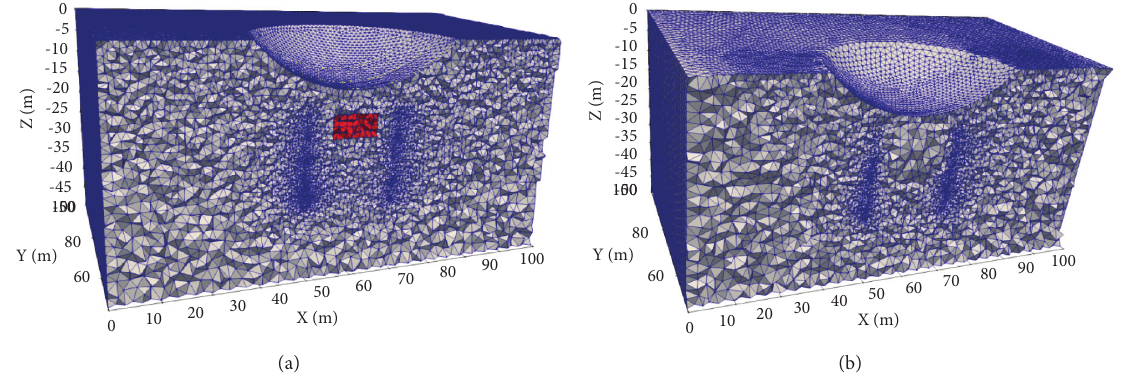
Figure 10: Forward and inversion grid of buried rectangular model under valley topography. (a) Forward mesh; (b) inversion mesh. process is shown in Figure 11(a). It can be seen from the figure with the measuring point, the total number of inversion grid that the data fitting is poor. The steady decline indicates that tetrahedral cells is 1169531. The selection of the inversion the L_BFGS inversion method has good convergence in this parameters is consistent with the inversion model under a flat paper. Figure 11(b) shows the slice of resistivity 3D inversion surface. The number of inversion iterations is 17 times. The result, while Figures 11(c) and 11(d) show the results of slices relative fitting error RMS of the data during the inversion